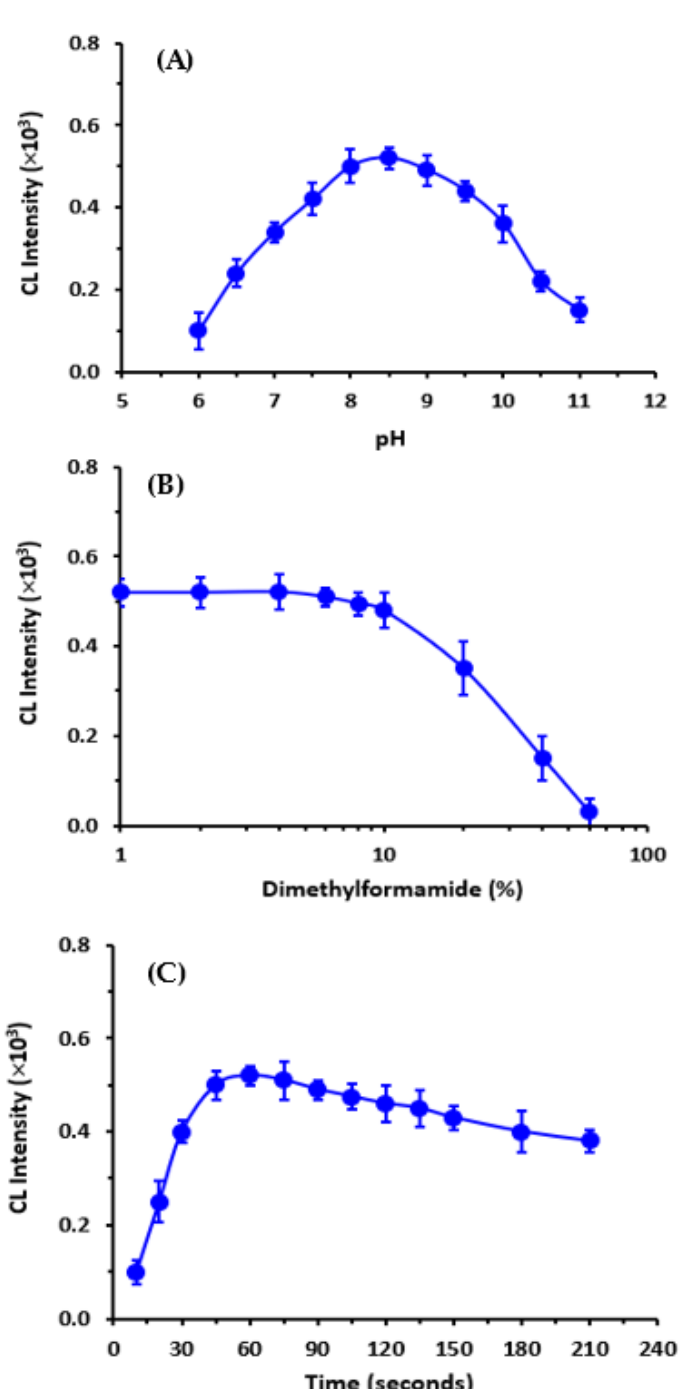
Figure 4. Effect of pH of ECS solution ( A ), dimethylformamide concentrations in the ECS ( B ) and kinetic of CL reaction ( C ) on the CL intensity induced by HRP-luminol-H 2 O 2 -IMP reaction. The values are mean of 3 determinations ± SD.